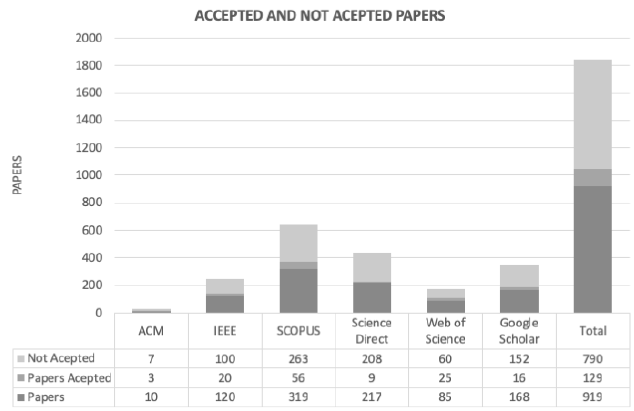
Figure 1. Accepted ratio from the DDBB—First Iteration [2].